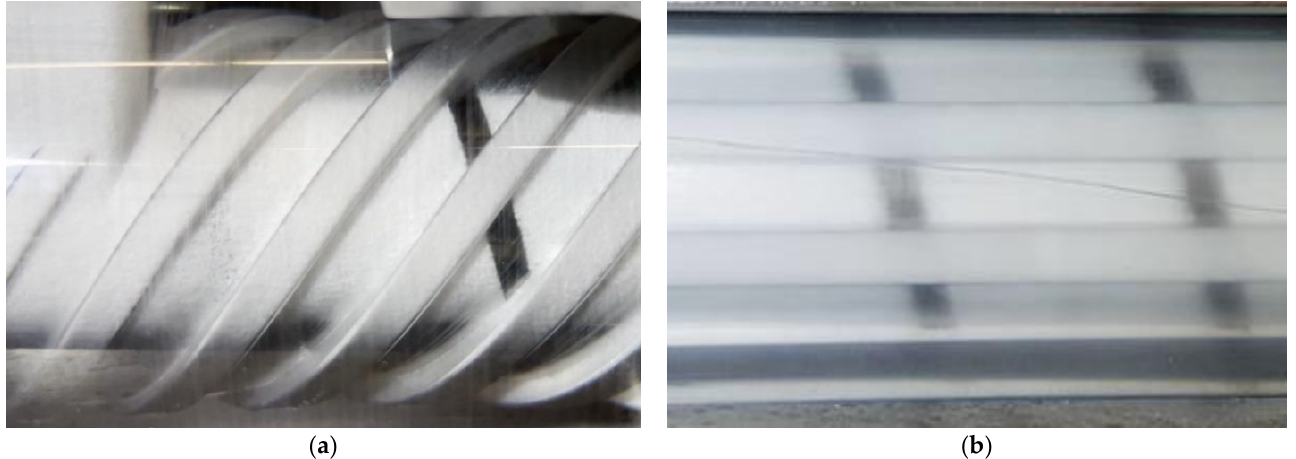
Figure 12. Powdery PE processed with a transparent PMMA barrel exhibiting ( a ) helical grooves, ( b ) axial grooves.